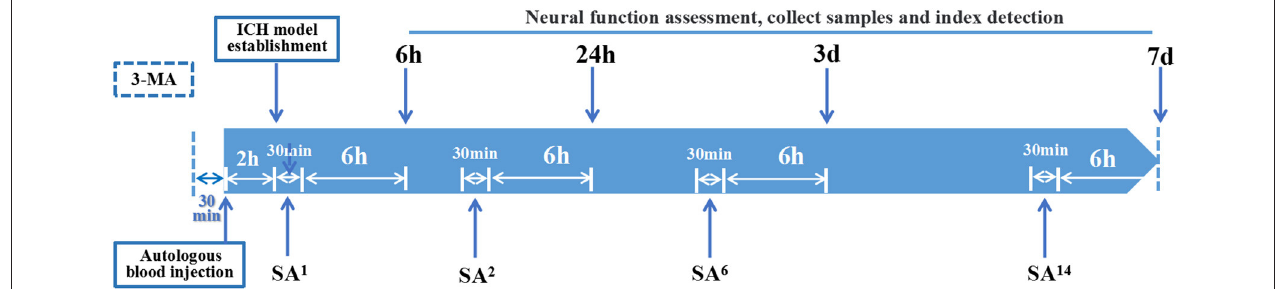
FIGURE 2 | Time axis: At 30min before establishing ICH model, 3-MA was injected into the lateral ventricle of rats in 3-MA and SA + 3-MA group. The success rate of ICH model establishment was evaluated 2h after autologous blood injection. All established rat models were given acupuncture for the first time. Rats were treated with SA once, twice, 6 times, and 14 times for 6-h, 24-h, 3-day, and 7-day models, respectively. Each treatment takes 30min. Neurological function, sampling and target detection were evaluated at 6h, 24h, 3 days, and 7 days after SA treatment respectively.